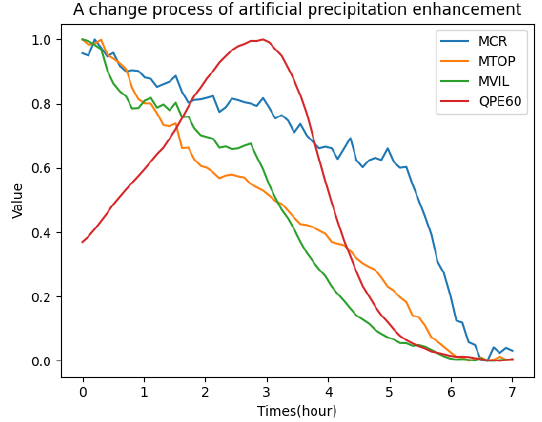
Figure 6. Duration of an artificial precipitation process.